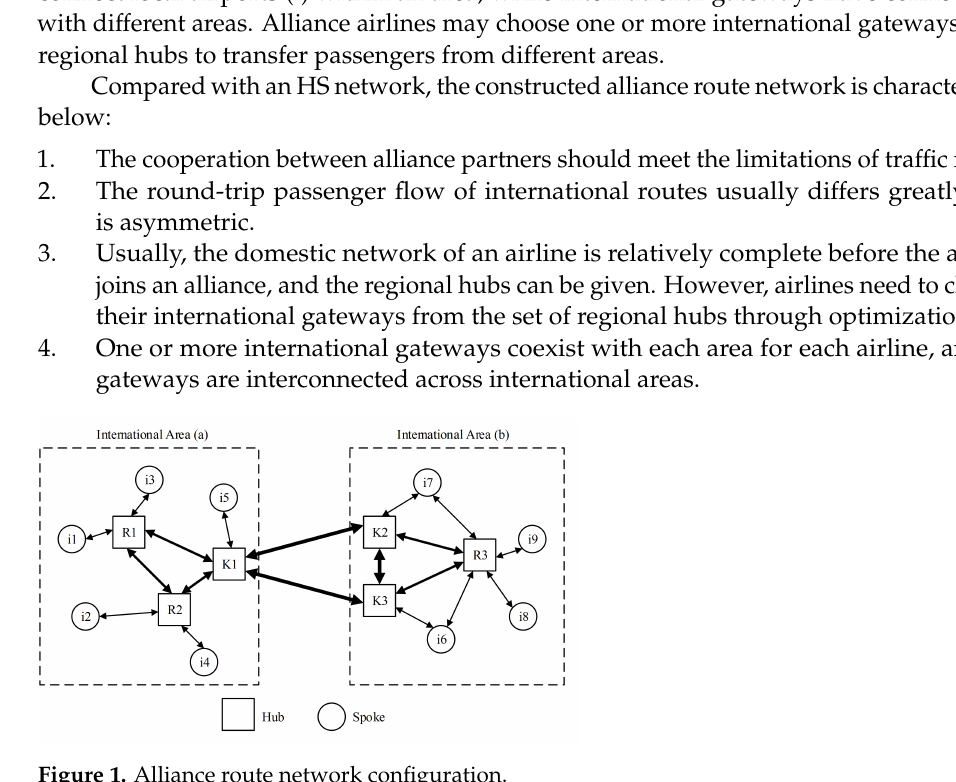
Figure 1. Alliance route network